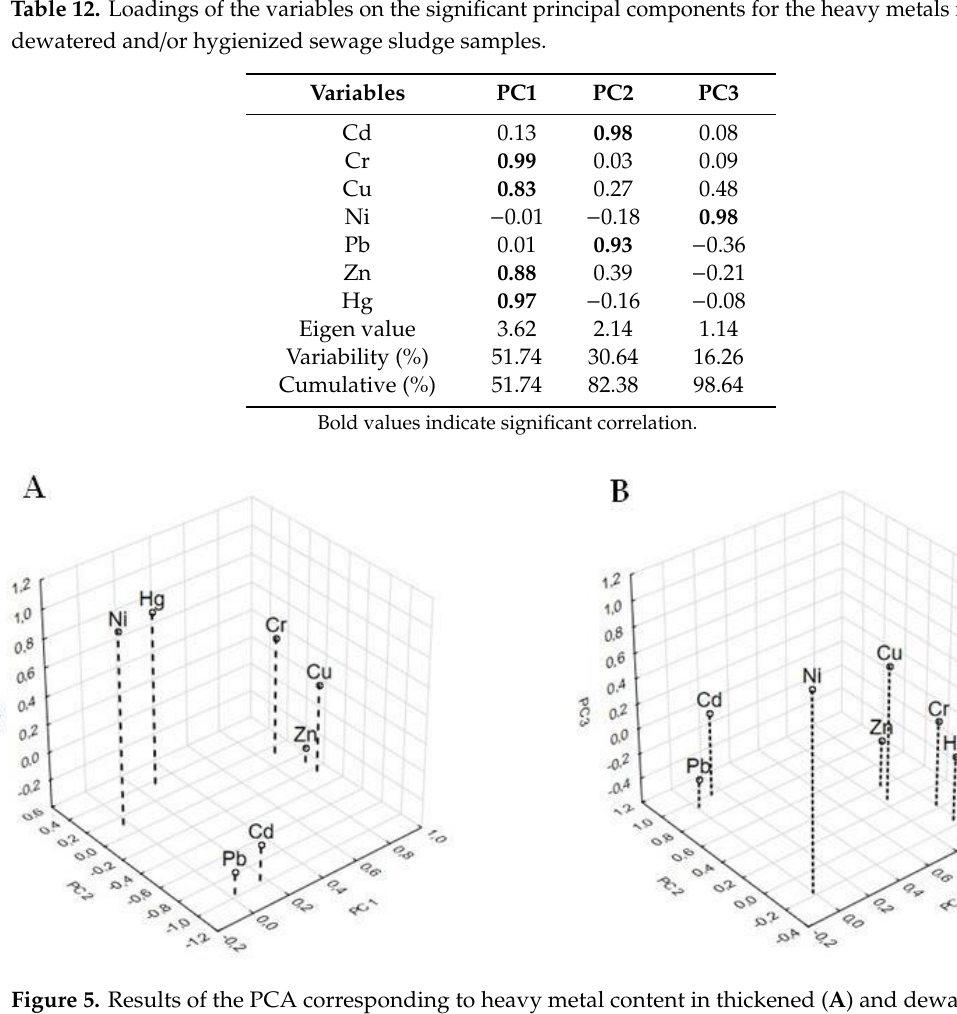
Figure 5. Results of the PCA corresponding to heavy metal content in thickened ( A ) and dewatered and/or hygienized ( B ) sewage sludge samples.